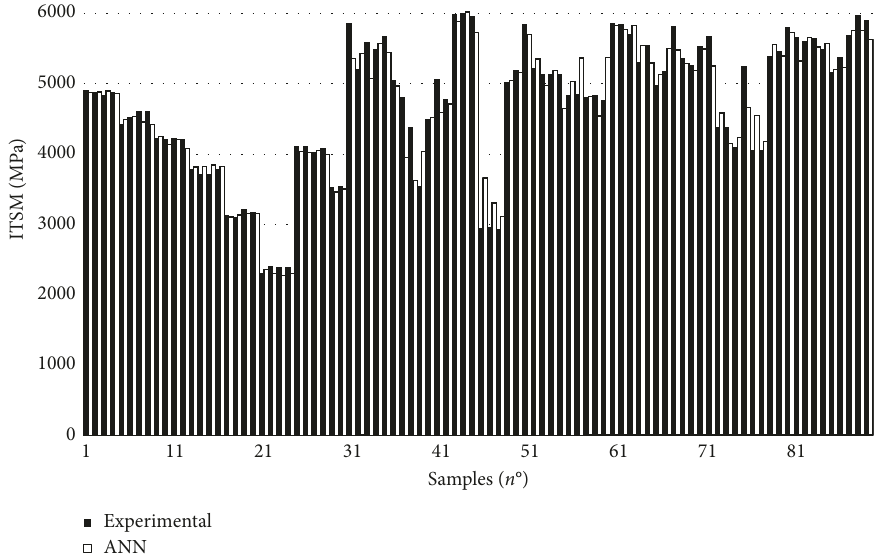
Figure 4: Experimental and ANN-predicted stiffness modulus data.